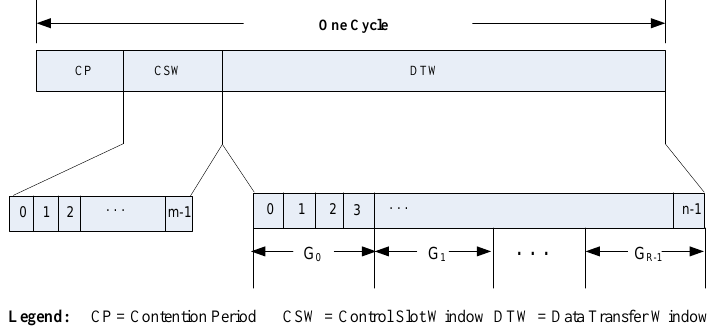
Figure 1. Cycle structure: a cycle is divided into contention period (CP), control slot window (CSW) and data transfer window (DTW). DTW is divided into R